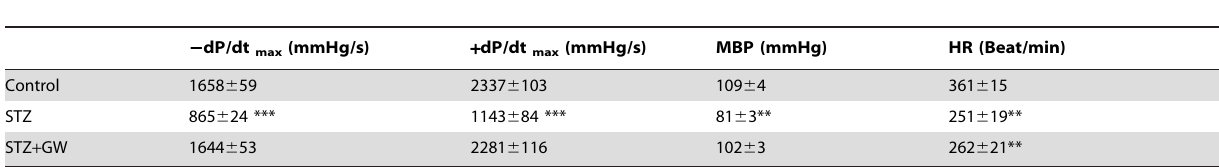
Table 1. Changes in Cardiac Performance of STZ Rats treated with/without GW0742 (7.5 mg/kg).